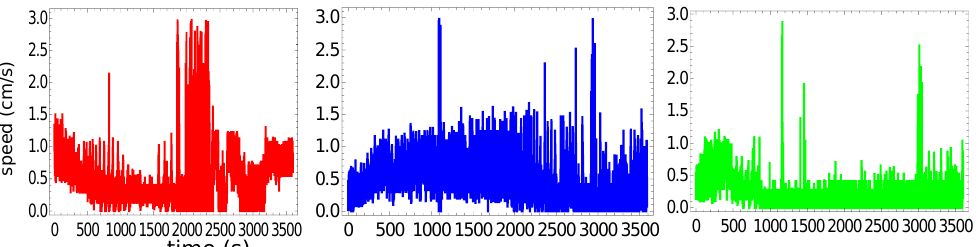
Figure 3. The radial distribution function g ( r ) of the positions of pill centers calculated from the distances illustrated in Figure 2. The same color is used to draw the radial distribution function and the trajectory.